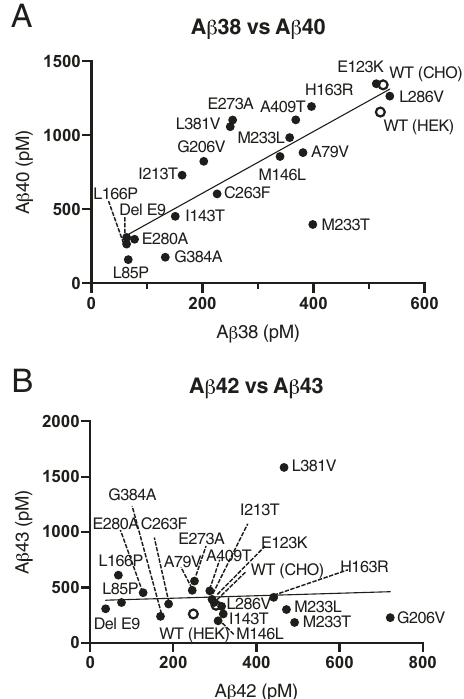
Fig. 2 Levels of each A β were generated based on a γ -secretase assay in vitro. A The levels of A β 40 were proportional to the levels of A β 38 in cells expressing WT or mutant PS1. B The levels of A β 43 were unchanged in PS1 mutants. Information about all PS1 mutations and the levels of A β by in vitro assay is indicated in Table S1. The open circles indicate WT PS1, and the closed circles indicate mutant PS1. ( n = 3).